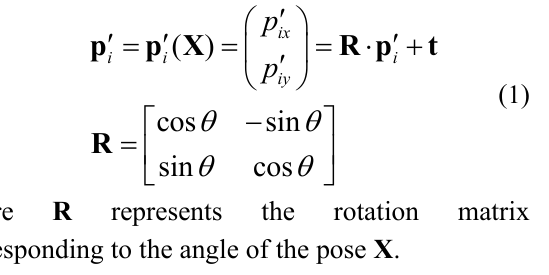
Fig. 4 Scan-matching result.